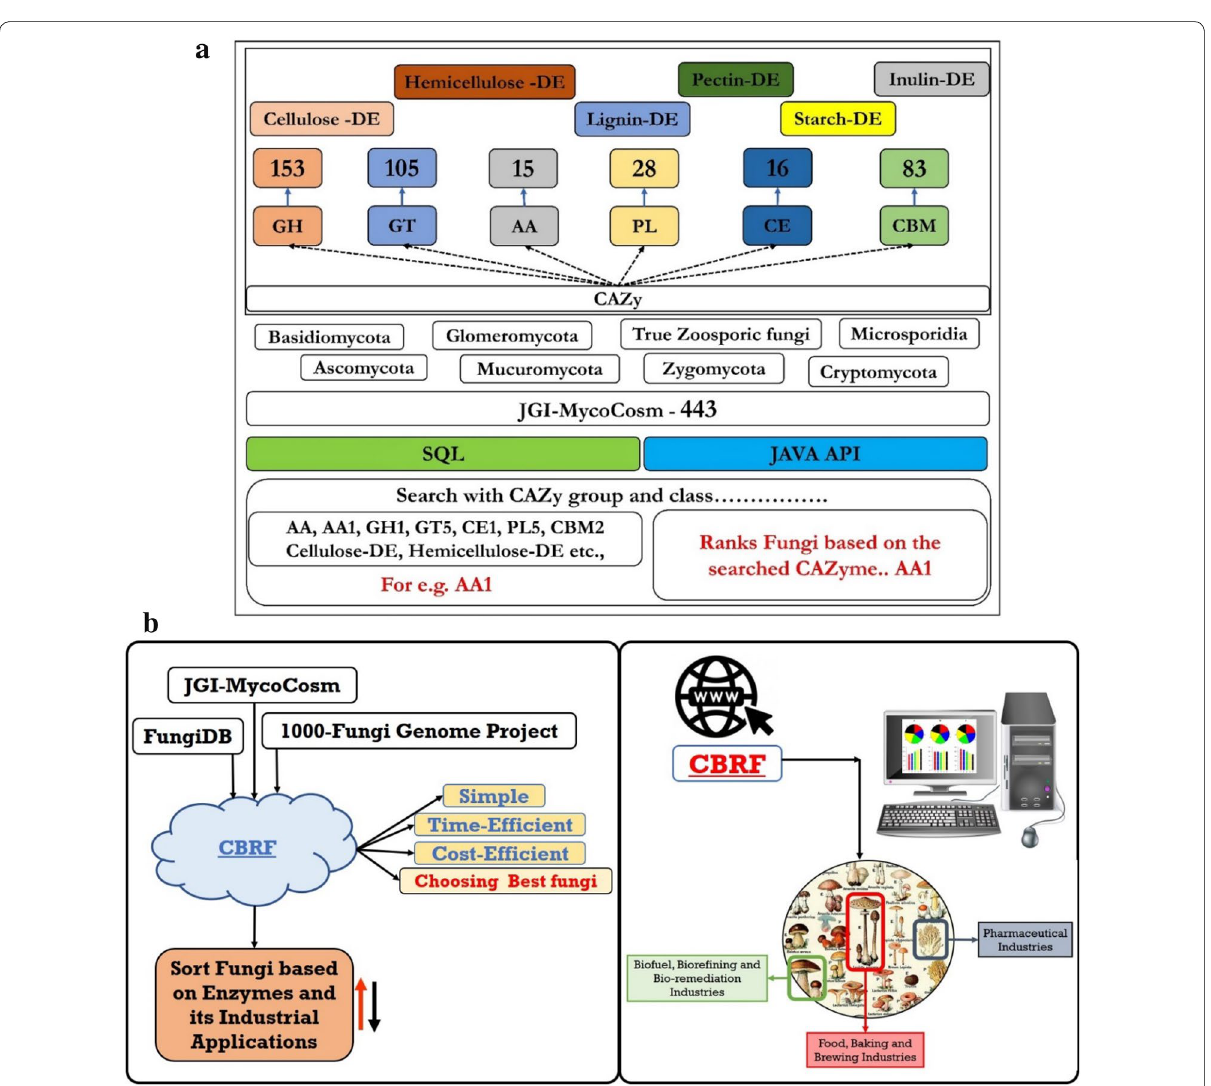
Fig. 4 a , b Pictorial illustration of layout and design of CBRF (CAZymes-based ranking of fungi web database) and different functions for retrieving the fungal information based on the search of